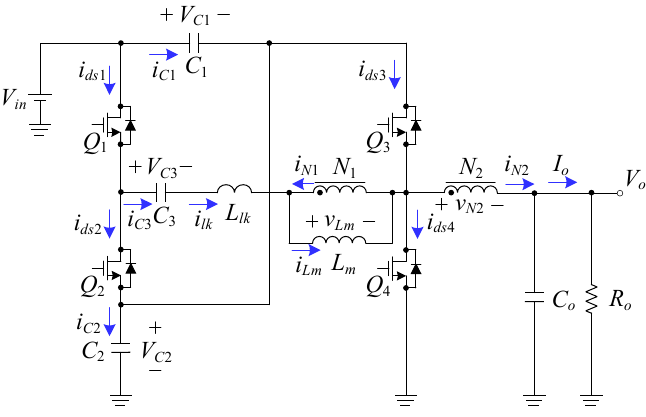
Figure 2. Equivalent circuit model of the proposed converter.